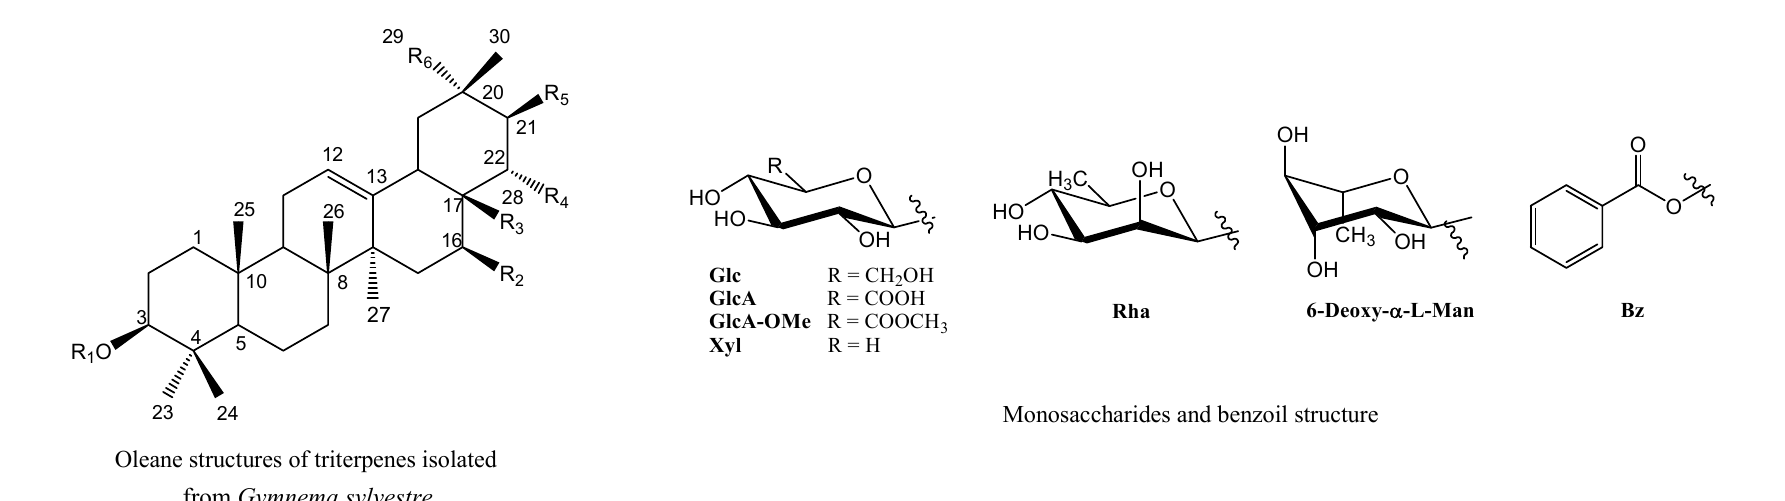
Figure 1. General structures of oleane triterpenes isolated from Gymnema sylvestre